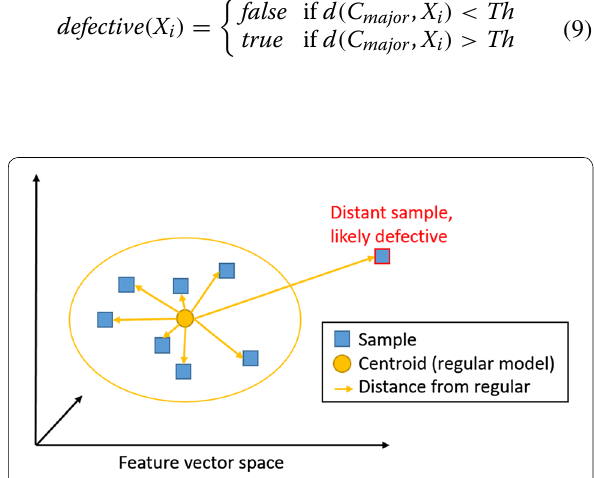
Algorithm 1: Pseudo algorithm for the